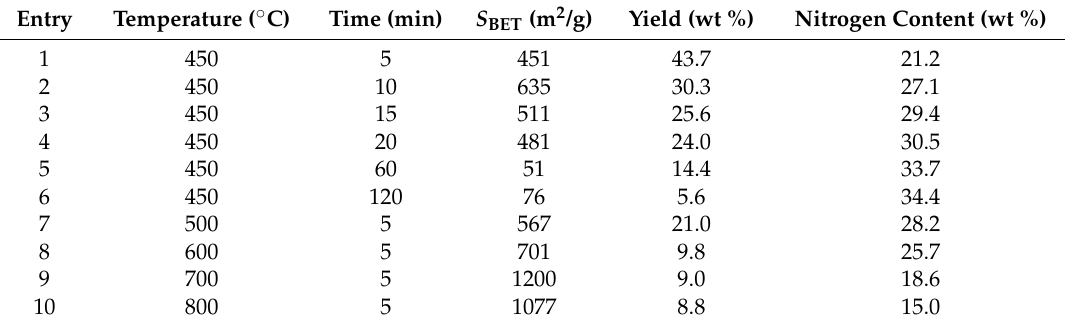
Scheme 1. Chemical structures of the ionic liquid ( left ) and poly(ionic liquid) ( right ) used in this work for aerobic carbonization. Table 1. Analysis results of carbon products obtained via pyrolysing ionic liquid (IL) in air at different holding times and temperatures. ( S BET : Brunauer–Emmett–Teller specific surface area.)